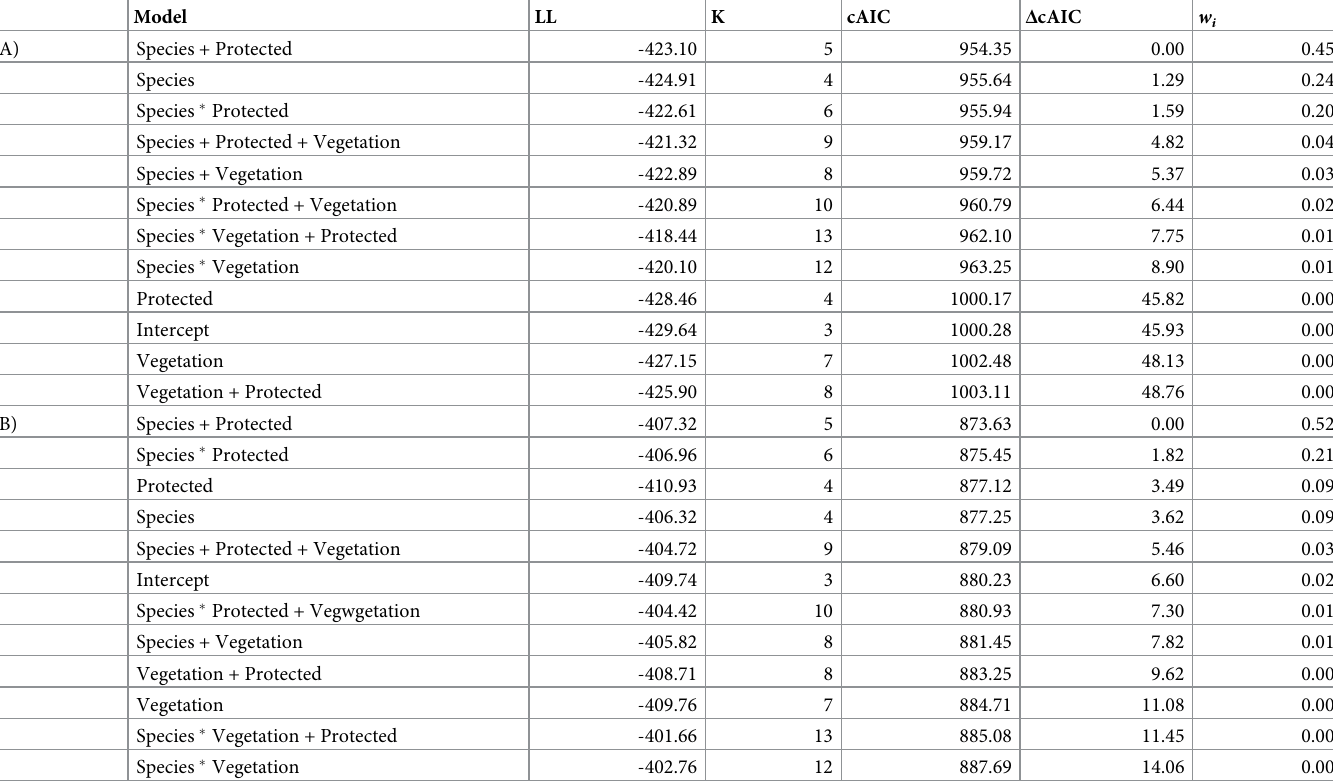
Table 1. Model selection comparing proportion of close photographs (A) and investigative photographs (B) of kit foxes and coyotes at scent stations throughout Utah, USA. Top models suggested differences between species and between protected versus unprotected land. Table contains conditional Akaike Information